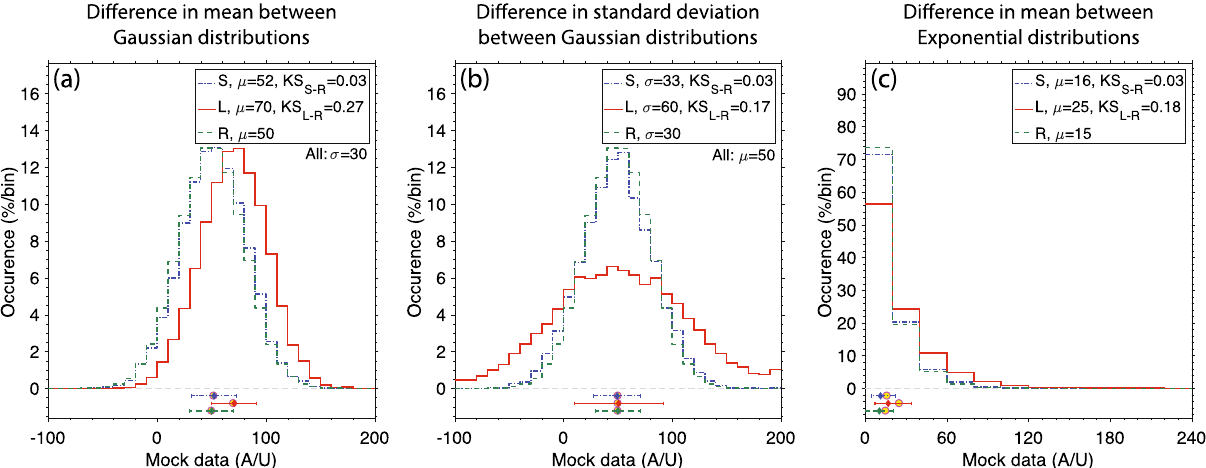
Figure 6. Illustrating the Kolmogorov–Smirnov test statistic (KS). Simulations with synthetic data generated according to Gaussian ( a , b ) and exponential ( c ) probability distributions. The results are present in a similar manner as Fig. 5. Each panel shows a reference case (R), and two additional cases with a large (L) and small (S) change in mean µ ( a , c ) and standard deviation σ (b). The resulting KS values are shown in the figure legend. In all panels, the R population has a size of 60,000, while the S and L populations have a smaller population size of 6,000. This is done to roughly match the difference in population sizes in Fig.